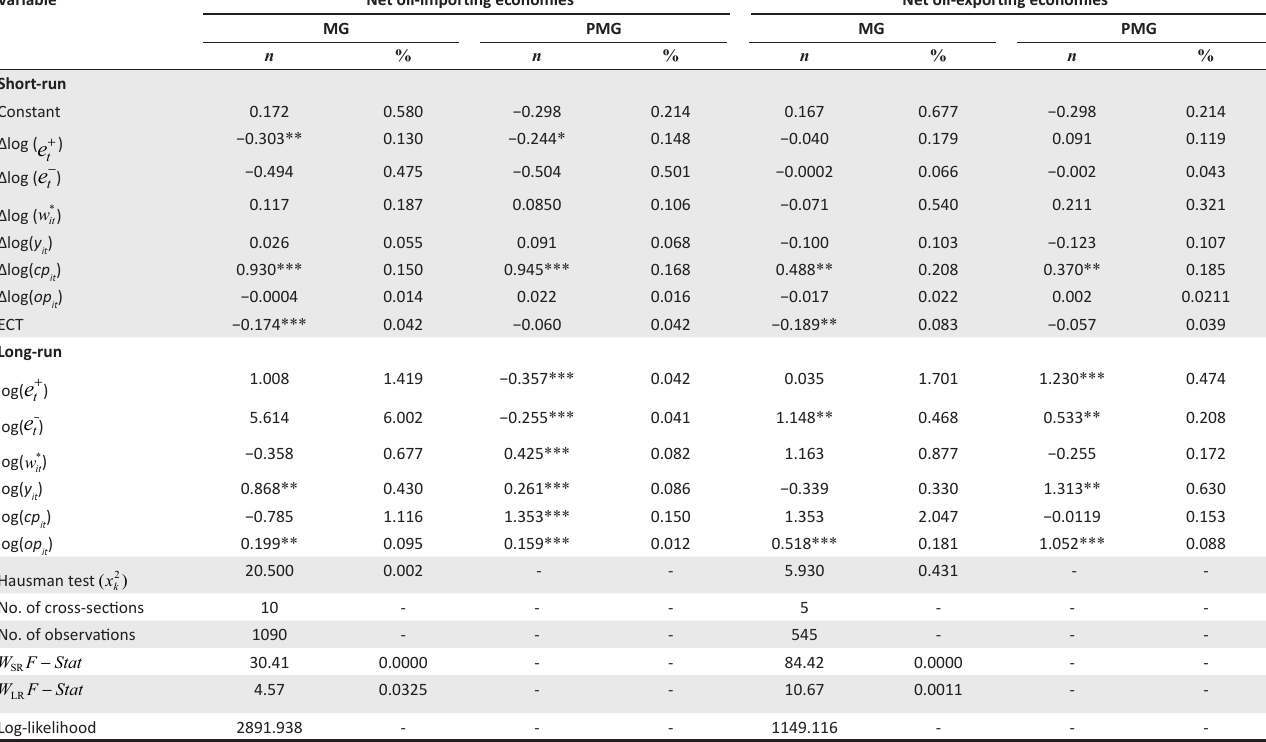
TABLE 4: Exchange rate pass-through panel regression results (asymmetric model without interaction term).